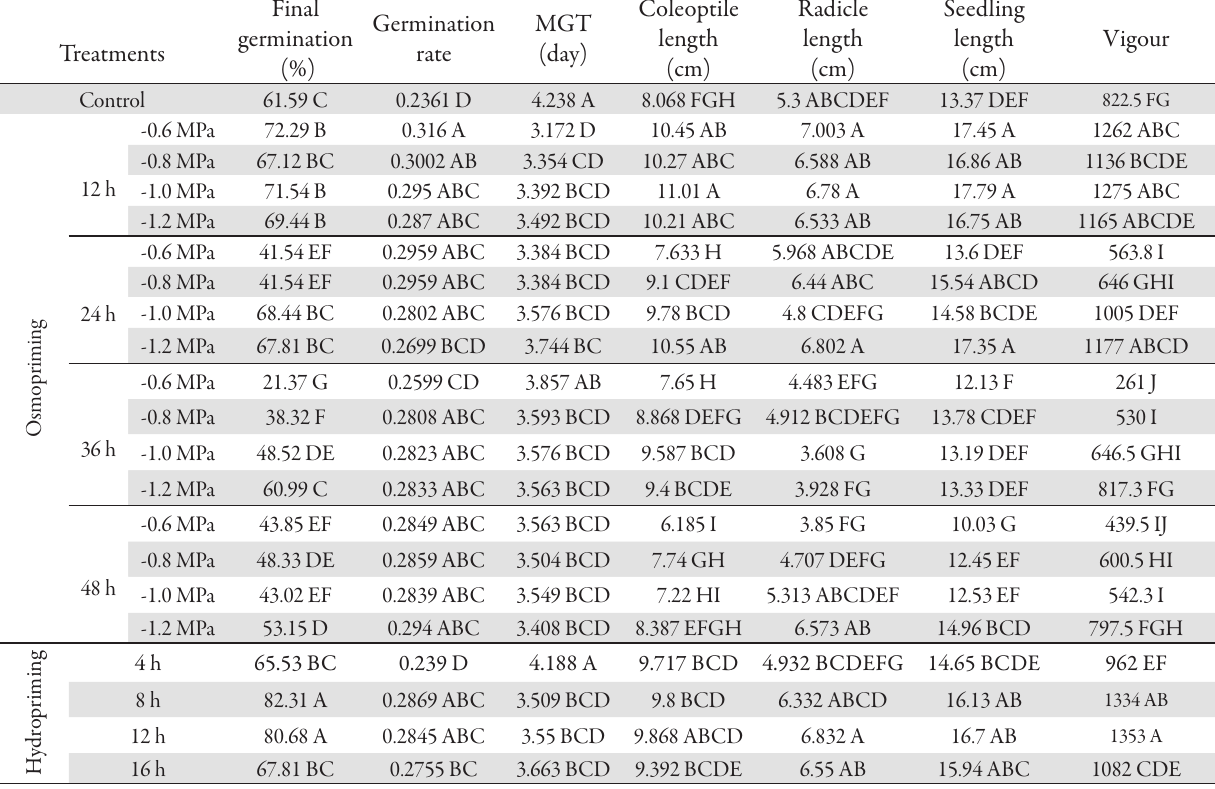
Tab. 2. Effect of priming treatments on the germination and seedling characteristics of Bromus inermis